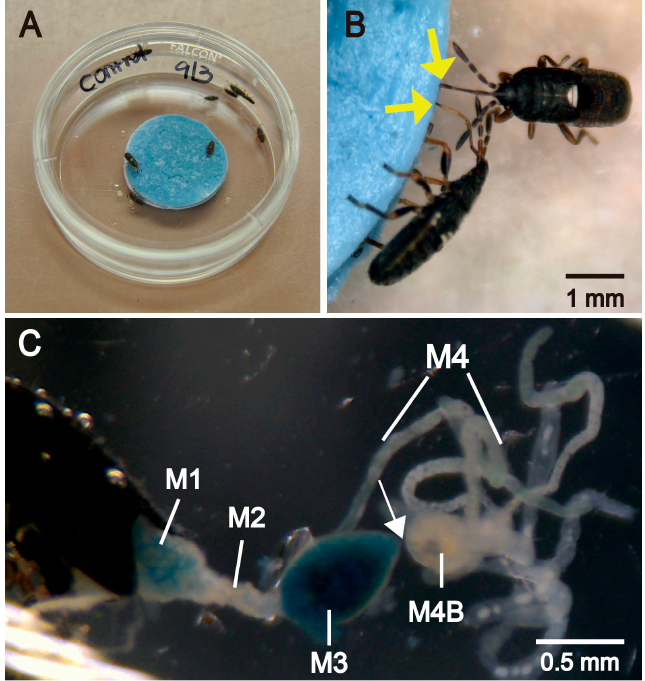
Figure 1. Oral delivery of antibiotics to Blissus insularis . ( A ) Fifth instars were placed into a feeding arena with liquid food supplemented with Evans Blue dye and antibiotics; ( B ) Fifth instars were feeding. Yellow arrows indicate the mouthparts of feeding B. insularis ; ( C ) Dissected digestive tracts from fifth instar B. insularis after 10-day exposure to the antibiotic treatments. Abbreviations: M1, midgut first section; M2, midgut second section; M3, midgut third section; M4, midgut fourth section with crypts; M4B, M4 bulb. Note the presence of dye in the M3, but not M4B or M4 section. Arrow indicates the thin, thread-like constriction connecting the M3 and M4B sections.